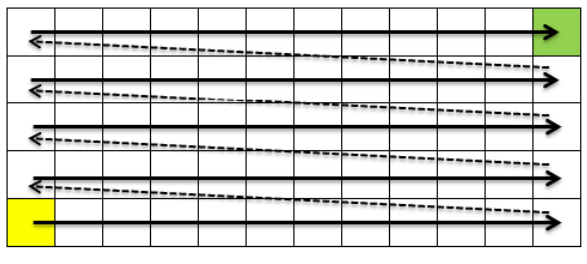
Figure 2. Scheme of a watermark linear reading.